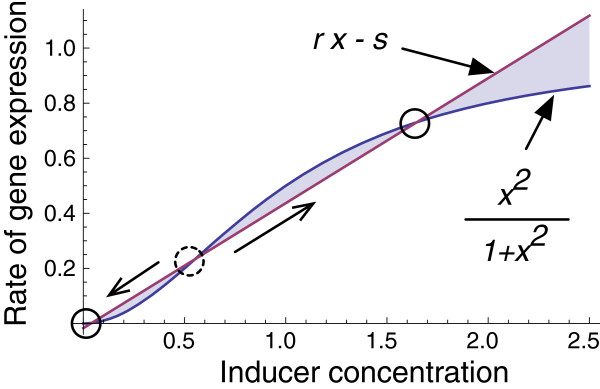
Nullclines of Equation 2. The differential equation has as many as three points where the derivatives are zero. The two extreme points (shown by solid open circles) correspond to the bistable states. The intermediate point (dotted open circle) is an unstable point.